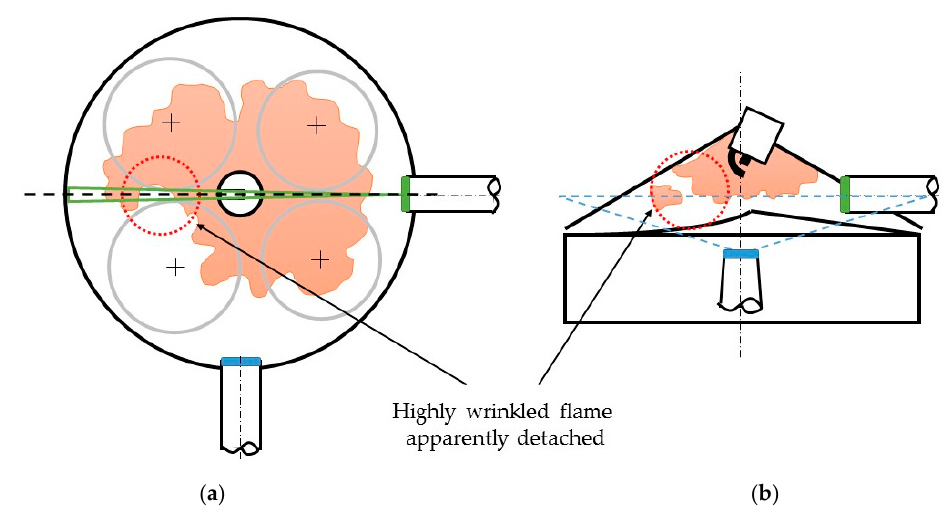
Figure 4. Highly wrinkled apparently detached flames: ( a ) top view; ( b ) side view.